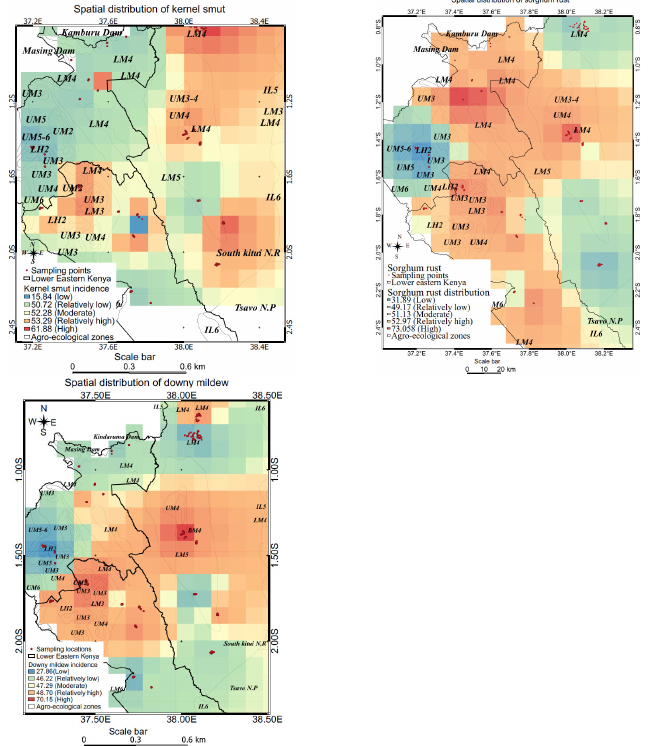
Figure 5. Inverse distance weighting (IDW) interpolated maps indicating the spatial distribution of major sorghum fungal disease incidence in lower eastern Kenya. UM = upper midland zone; LM = lower midland zone; LH = lower highland zone; IL = inner lands. High rust disease incidence rates (>51%) were recorded in all agro-ecological zones of Makueni County, and rust was prevalent in the average humidity areas of UM4, LM4, LM3 and LM5, as well as parts of LM6 (Figure 5). Relatively lower rust incidence rates ranging from 31.8% to 49%were recorded in both high-humidity areas (UM3, UM5, UM6 and UM2) and hot, dry lowland areas (LM5, LM6, IL5 and IL6, as well as parts of LM4) (Figure5).